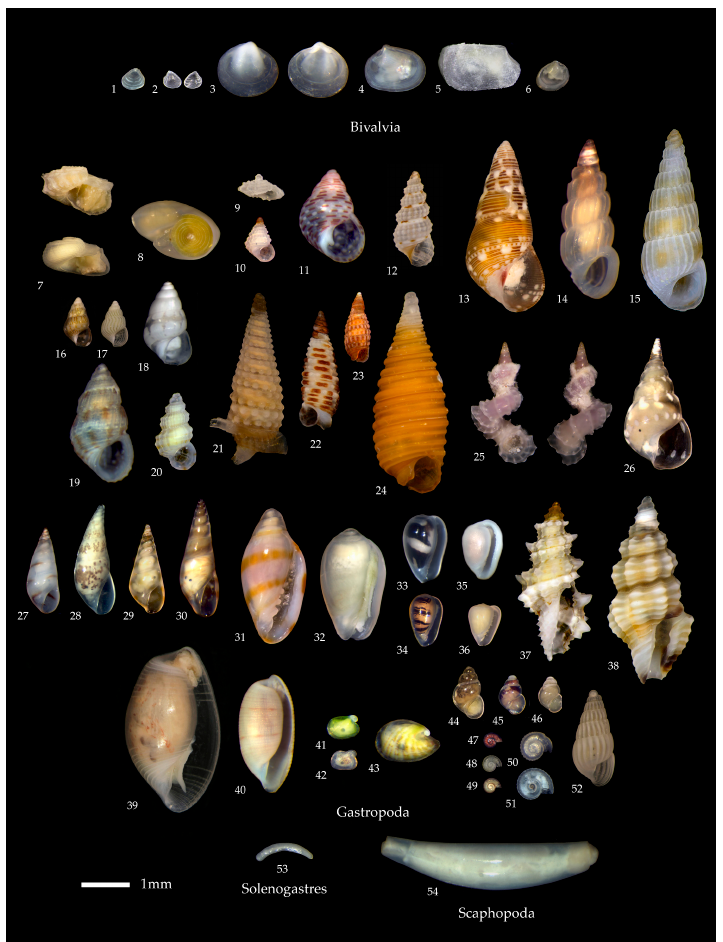
Figure 1. Diversity of small molluscs from recent Western Australian field trips (2011–2015). 1–2.